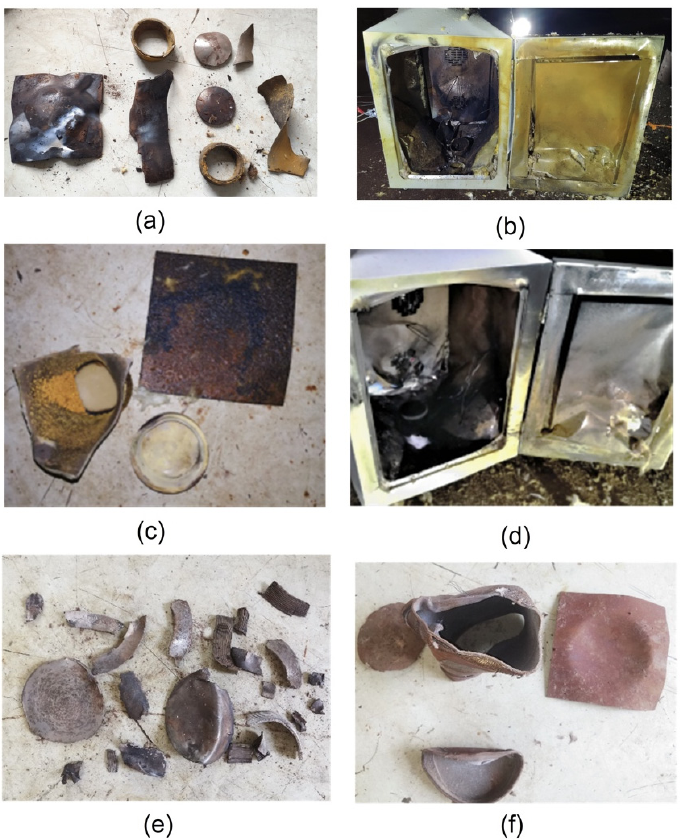
Figure 5. Response status of the slow cook-off experiment: ( a , b ) The first response status; ( c , d ) The second response status; ( e , f ) The third response status.